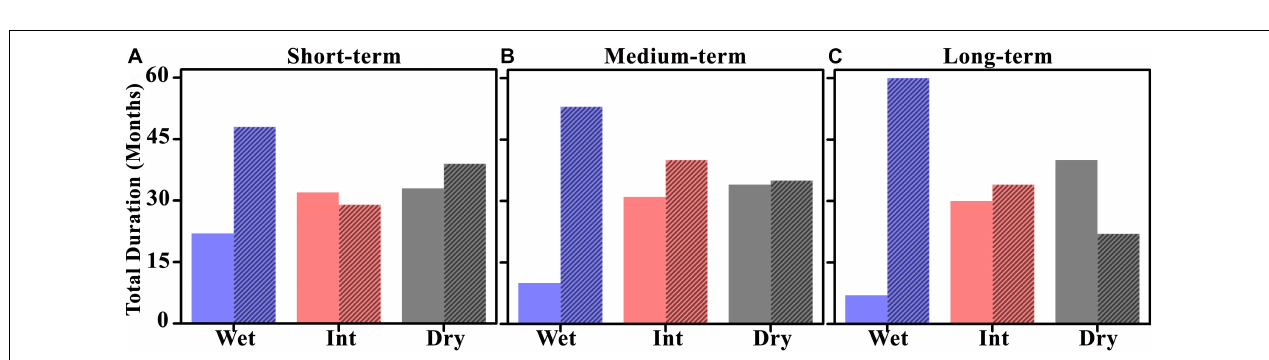
FIGURE 6 | Total duration (Unit: Months) of (A) short-term (SPEI-3 < –1), (B) medium-term (SPEI-6 < –1), and (C) long-term (SPEI-12 < –1) droughts events over the wet, intermediate and dry region in Mahaweli river basin (MRB) for early (P 1 ; 1985–1999) and late (P 2 ; 2000–2015) periods. The normal bars represent the early period, while black hatched bars for the late period. The letter Wet, Int, and Dry represent wet, intermediate, and dry regions in MRB, respectively.